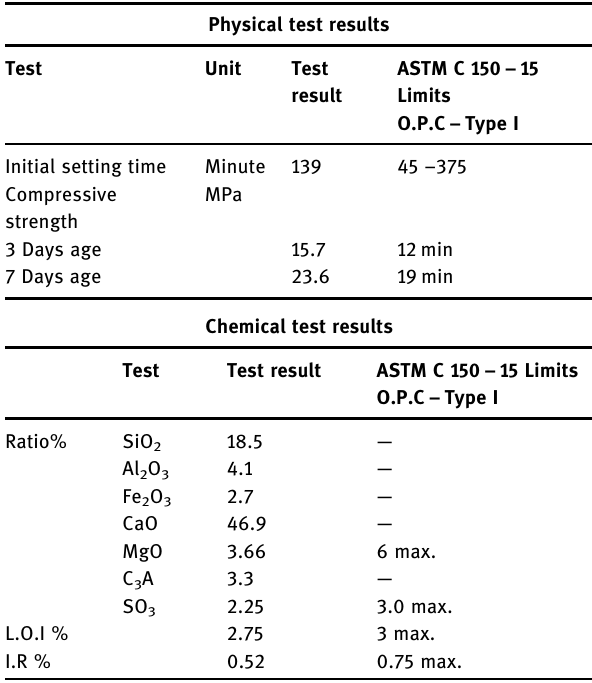
Table 1: Chemical composition and physical test results of the